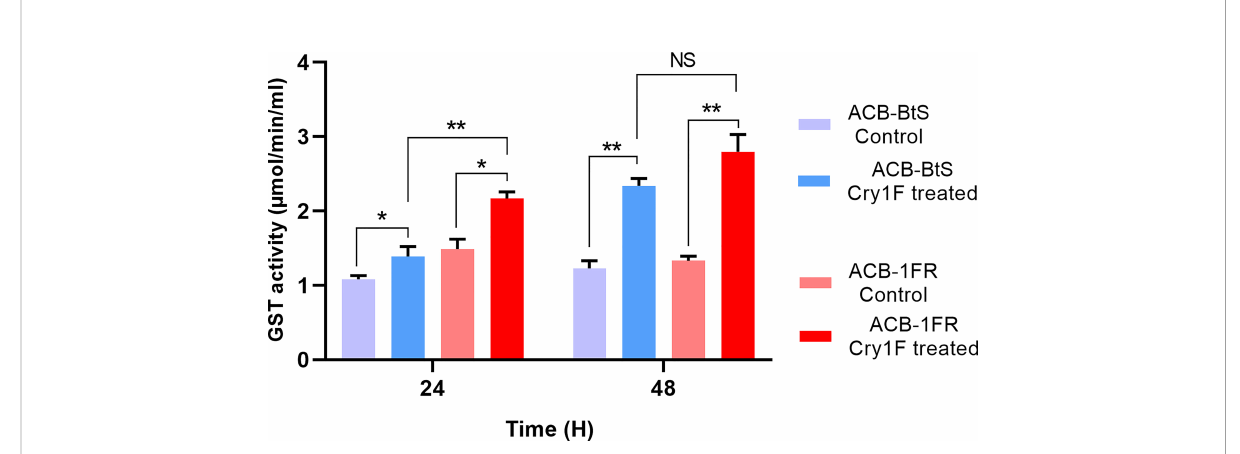
FIGURE 3 Glutathione S-transferase (GST) activity in hemolymph of susceptible and resistant Asian corn borer (ACB) larvae after exposure to Cry1F (LC 50 dosage: ACB-BtS - 1.2 m g/g and ACB-FR 1,075 m g/g, toxin/diet). Asterisk represents statistically signi fi cant difference (Student ’ s t-test, * P <0.05, ** P <0.01), NS, not signi fi cant.